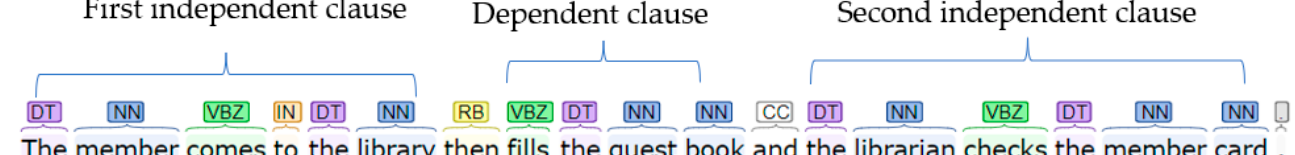
Figure 6. The example of compound-complex sentence. Algorithm 5. Fact type from compound-complex sentence